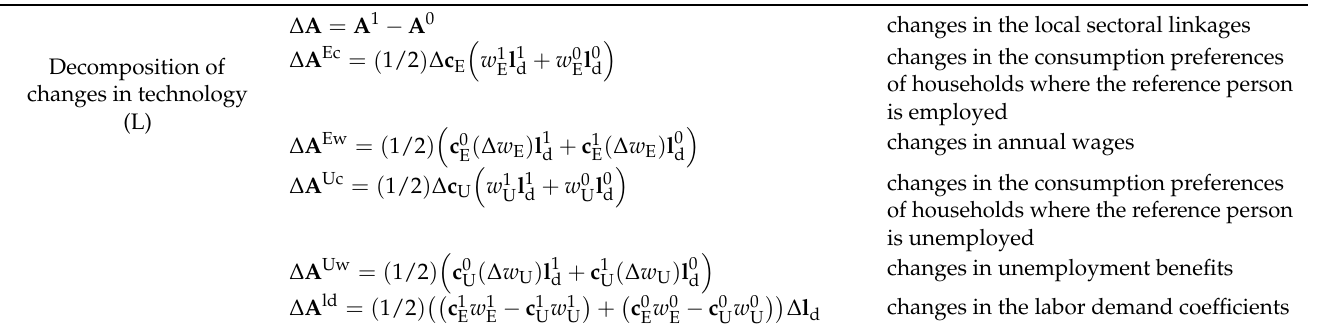
Table A1. Definition of components involving the SDA of changes in technology